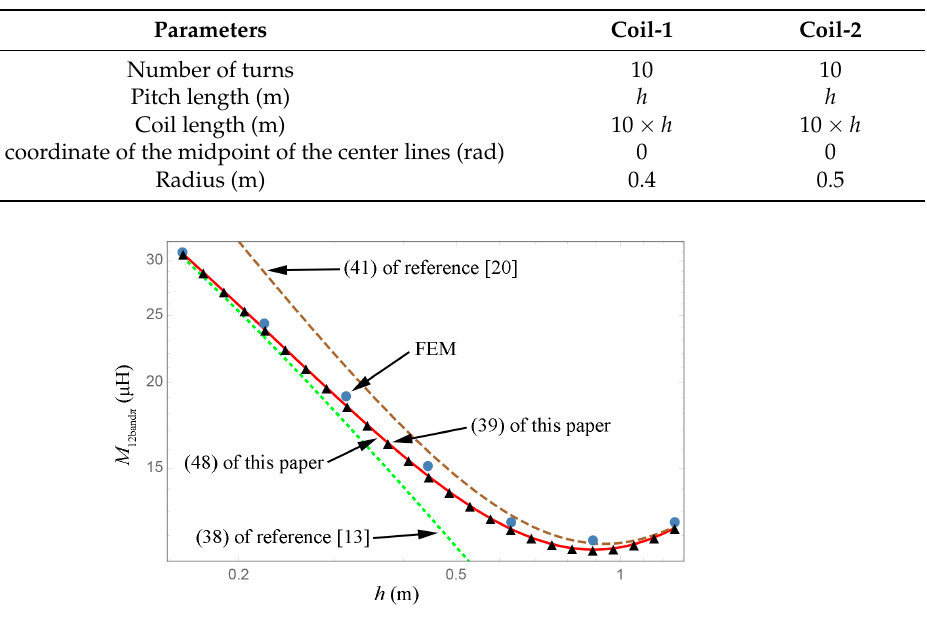
Figure 15. Pitch length ( h ) dependence of the mutual inductance ( M 12band ) of tape coils with equal radius.